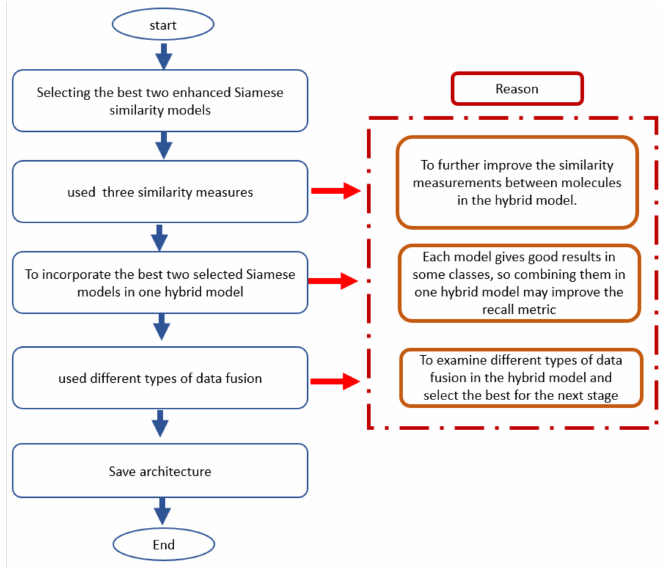
Figure 1. The steps for incorporating two enhanced Siamese similarity models into one hybrid